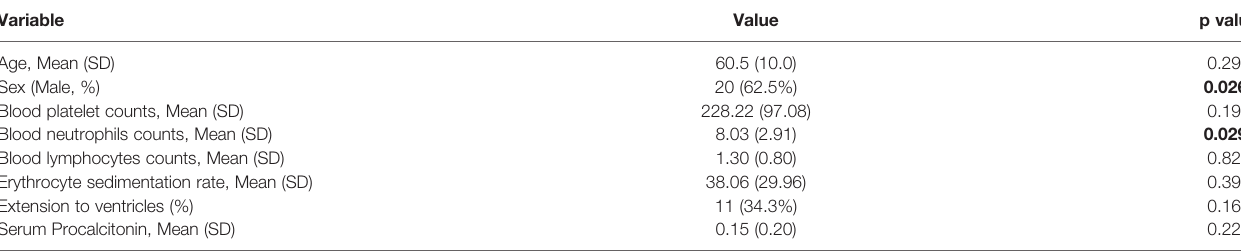
TABLE 2 | Multivariate linear regression analysis of the risk factors for AQP2 in patients with ICH (n=32).